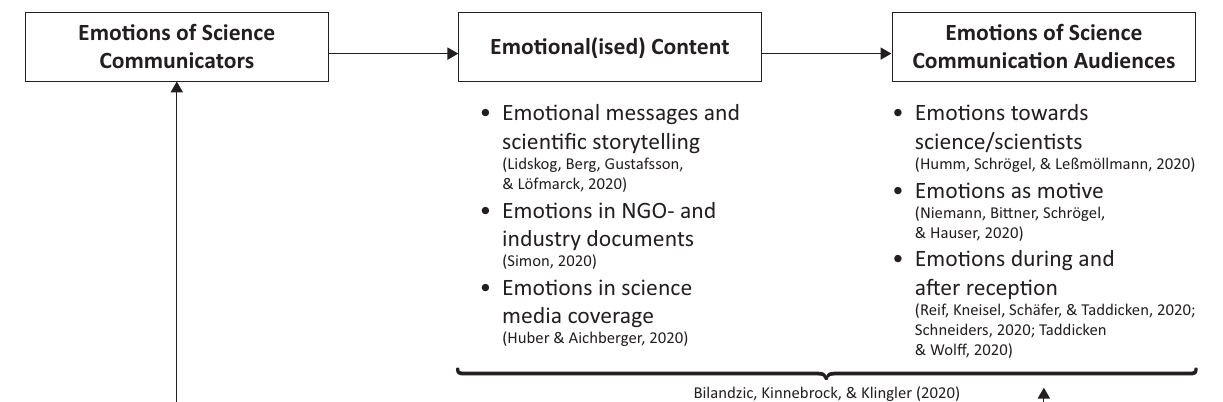
Figure 1. Overview of articles in this issue. conference keynote in Braunschweig, Rainer